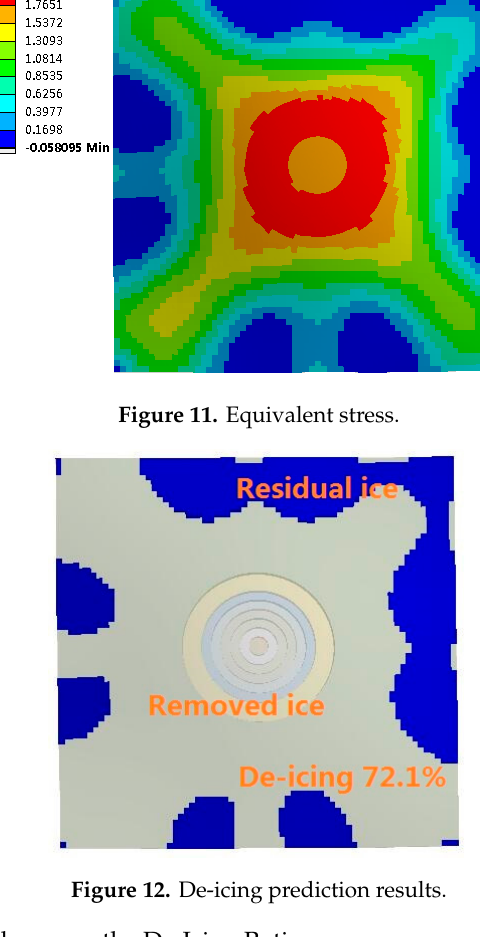
Figure 12. De-icing prediction results.